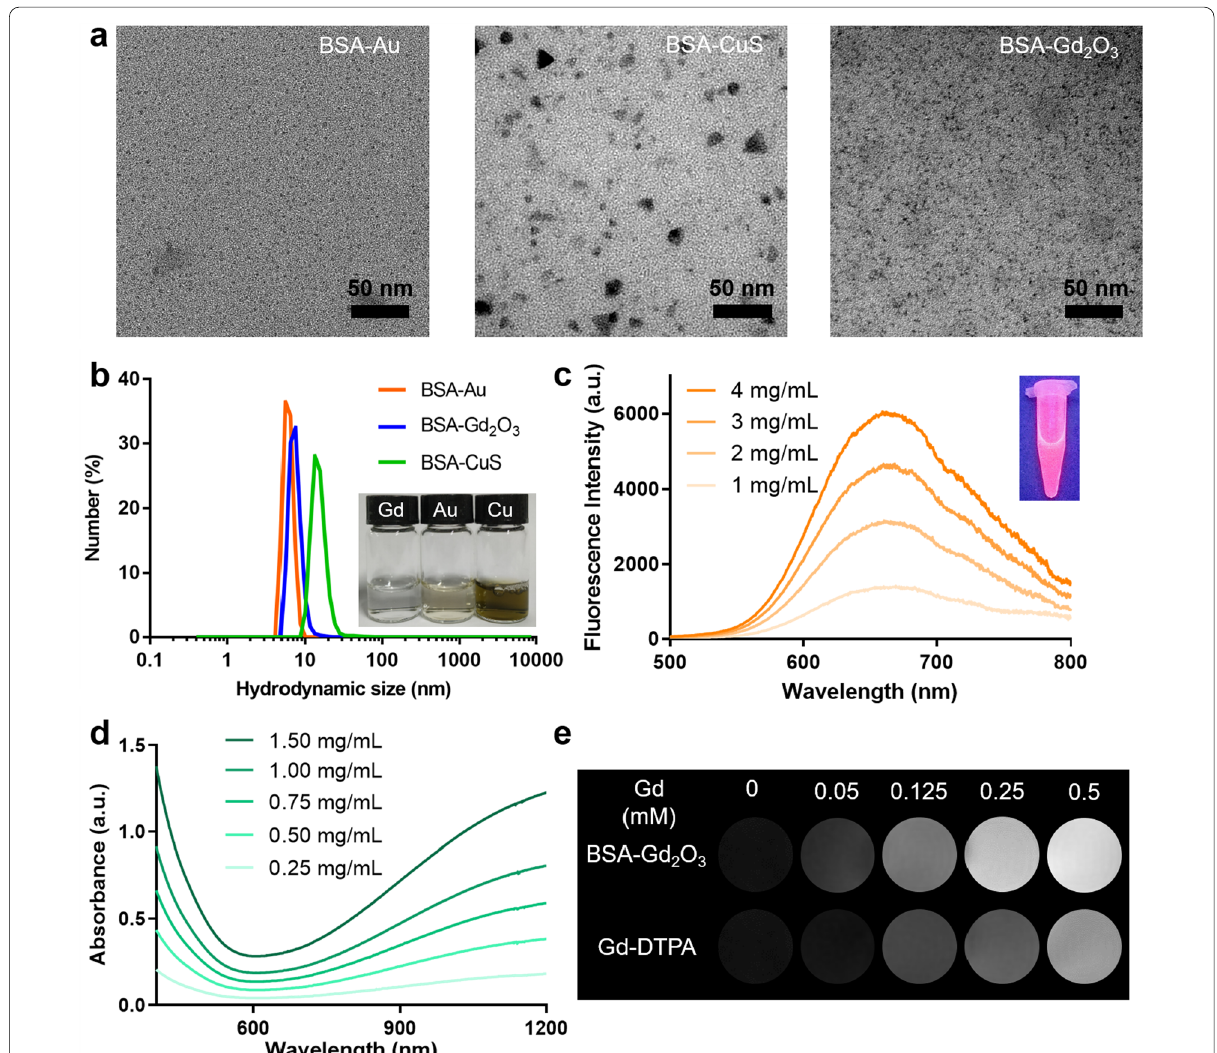
Fig. 2 Characterization of BSA-templated NPs. a TEM images of BSA-Au, BSA-CuS, and BSA-Gd 2 O 3 NPs. b Hydrodynamic sizes of BSA-Au, BSA-CuS, and BSA-Gd 2 O 3 NPs. Inset: The photographs of obtained BSA-templated NPs dispersed in water (4 mg/mL). c Fluorescence spectra of BSA-Au NPs with different concentrations. Inset: The photographs of BSA-Au NPs solution (4 mg/mL) under ultraviolet light. d Absorption spectra of BSA-CuS NPs with different concentrations. e T 1 -weighted magnetic resonance images of BSA-Gd 2 O 3 NPs and Gd-DTPA aqueous solutions with different concentrations of